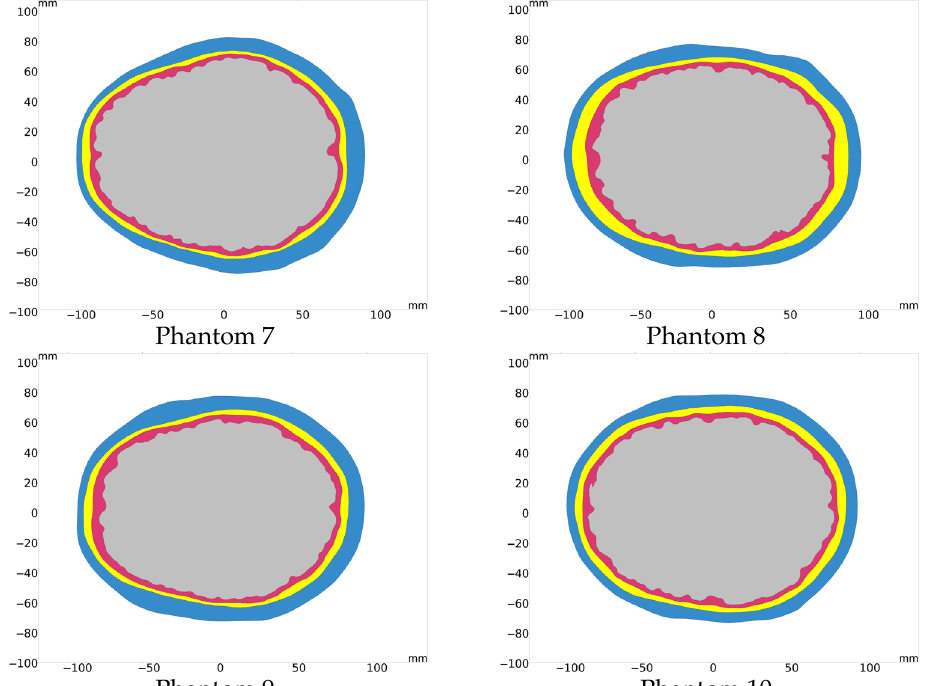
Figure A1. 10 different human head model geometries based on real subjects.